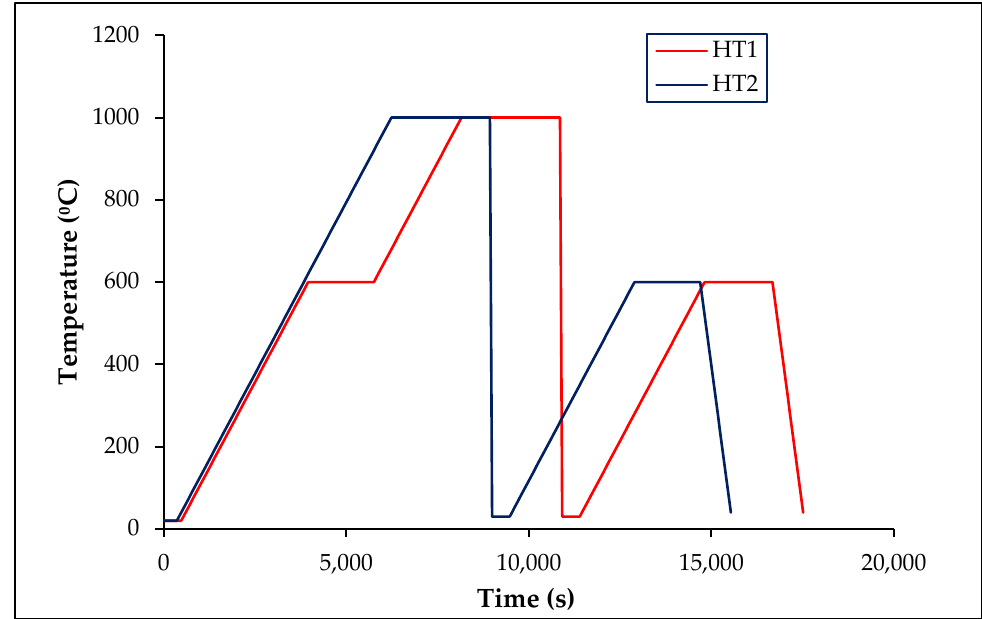
Figure 1. Heat-treatment processes: HT1 and HT2.